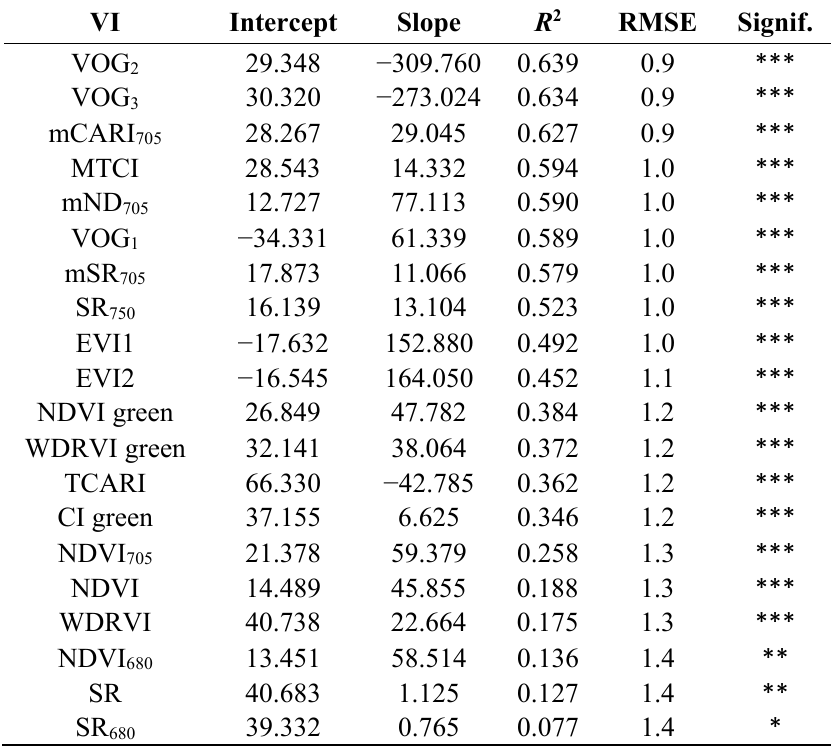
Table 5. Relationship between CC and VIs for A. germinans ( n = 121).